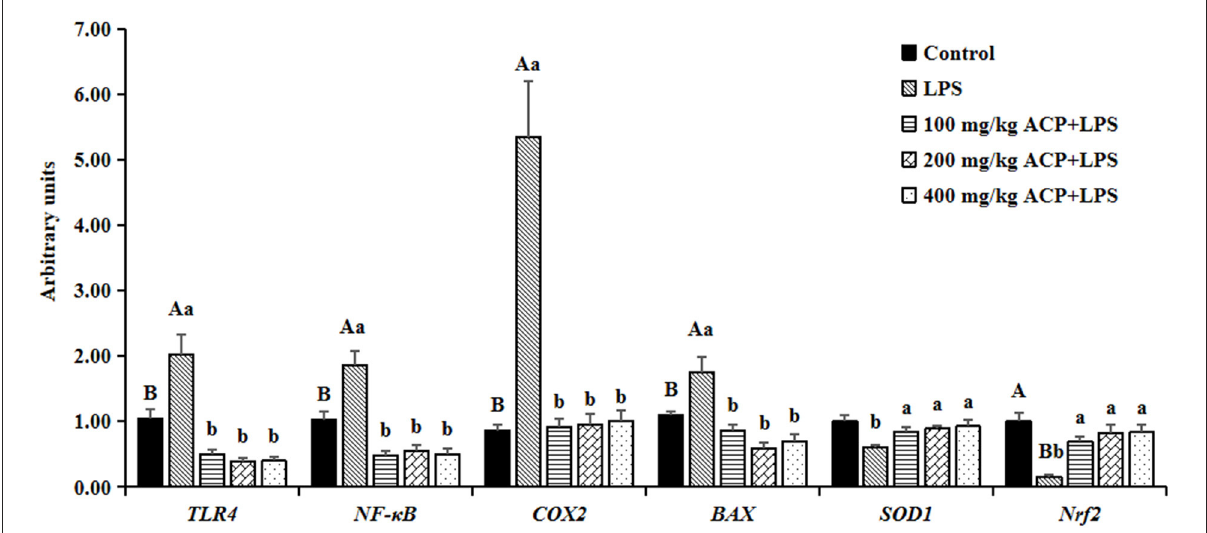
FIGURE1 Effects of Antrodia cinnamomea polysaccharide on mRNA expression abundance of antioxidant and anti-damage genes in liver of slow-growing broiler breeds challenged with LPS a . Values are means of 6 replicates per treatment with 2 samples each. LPS, Lipopolysaccharide; ACP, Antrodia cinnamomea polysaccharide; TLR4, toll-like receptor ( TLR ) 4 ; NF- κ B , nuclear factor kappa B; COX 2, Cyclooxygenase 2; Nrf2 , nuclear factor erythroid-2 related factor 2; SOD1 , superoxide dismutase-1; BAX , B-cell lymphoma/leukemia-2-associated X protein; Control, basal diet group; LPS, basal diet + LPS stress group. 100 mg/kg ACP + LPS, basal diet + LPS stress + 100 mg/kg ACP group. 200 mg/kg ACP + LPS, basal diet + LPS stress + 200 mg/kg ACP group. 400 mg/kg ACP + LPS, basal diet + LPS stress + 400 mg/kg ACP group. a Data are expressed as means ± SEM. SEM, standard error. Capital letters indicate statistically significant ( P < 0.05) differences between control group and LPS group by Student’s t -test; small letters indicate statistically significant ( P < 0.05) differences of